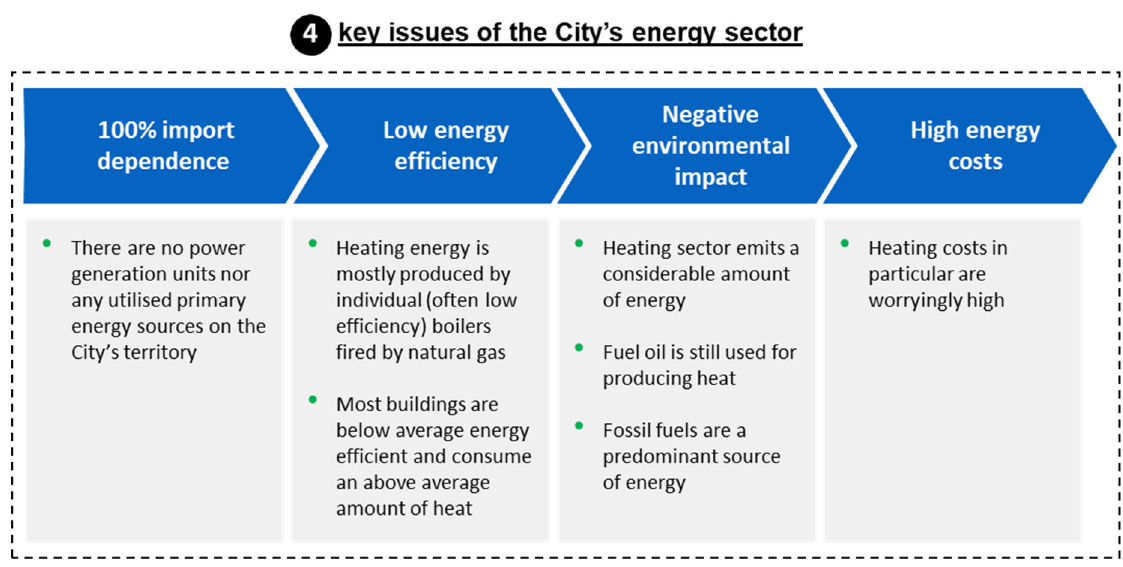
Figure 8. The city’s four key problem